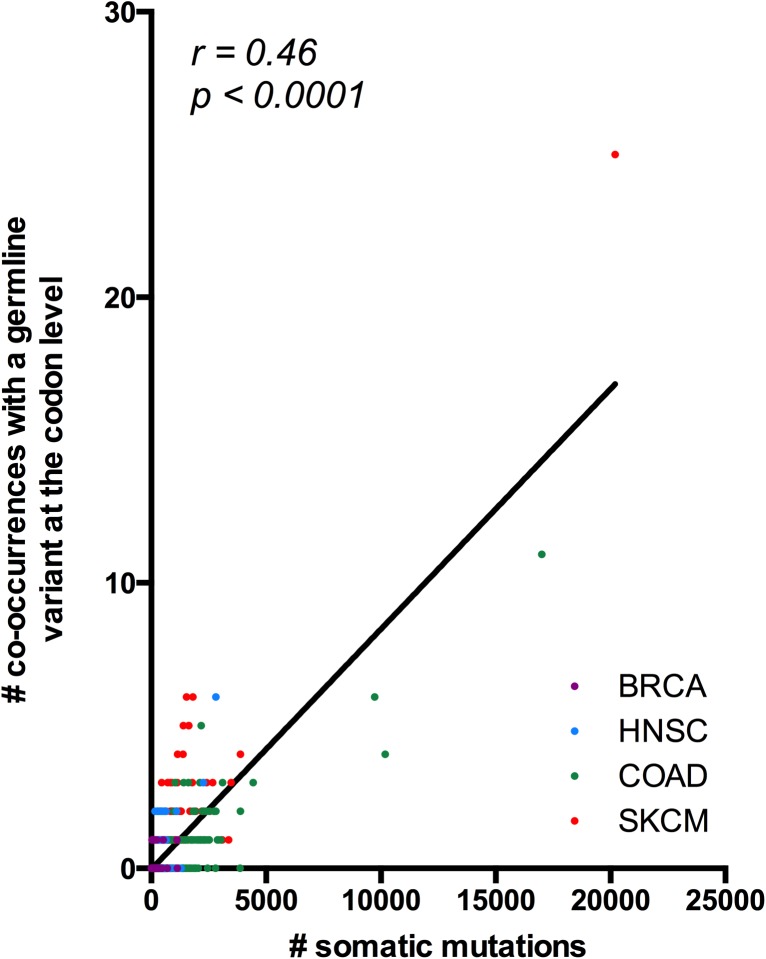
Linear relationship between somatic variant burden and codon-level co-occurrences between germline and somatic variants.Points denote individual patients and are colored by tumor type; solid line represents the linear regression on all points. The number of co-occurrences was calculated as the number of affected codons per patient, regardless of whether a codon was affected at two or three total positions.